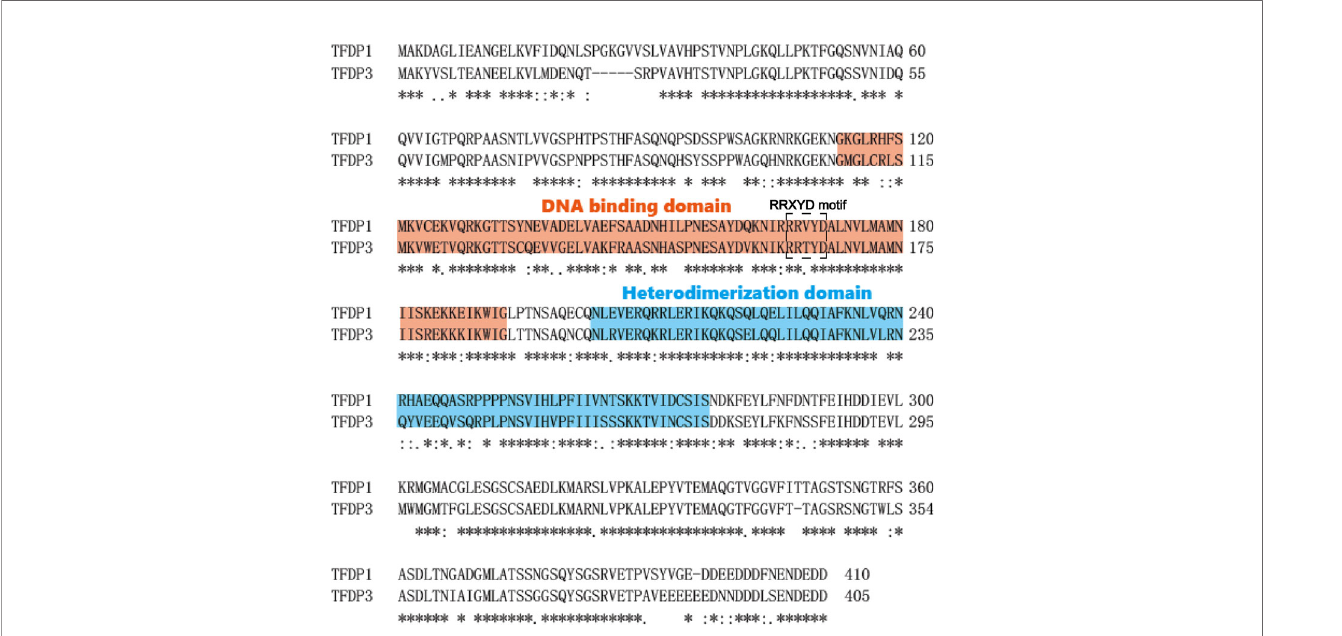
FIGURE 2 | Amino acid sequence alignment of TFDP3 and TFDP1. Complete sequence of TFDP3 and comparison with TFDP1 using single-letter amino-acid code. Identical residues are indicated by “ * ” and similar residues by “(cid:129) , ” and the missing residues with a dash. The spanning of the DNA-binding domain is labeled in red, and the heterodimerization domain is labeled in blue. The RRXYD DNA recognition motif is circled by dotted